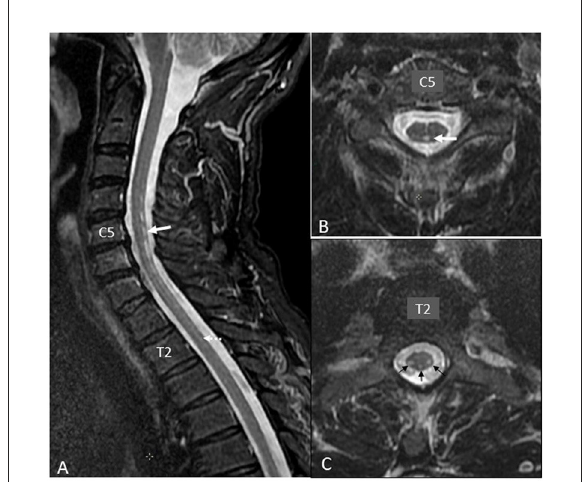
FIGURE1 Spinal MR imaging (MRI) workup. (A) Mid-sagittal T2-weighted view from C0 to T5 showing linear hypersignal intensity within posterior columns prominently at the level of C5–C6 (white arrow). At the thoracic level, only faint signal intensity changes were suspected (dotted arrow at T2 level). (B) Axial transverse T2-weighted view at C5 level showing the posterior mid-sagittal focus of abnormal hypersignal intensity (arrow) reflecting elective tissue damage to the posterior columns. (C) Axial transverse T2-weighted view at T2 level showing decrease in size of tissue damage within posterior columns (middle arrow), but the appearance of abnormal hypersignal intensity within both crossed cortico-spinal tracts (lateral arrows), which were mostly outside slice location on mid-sagittal T2 view